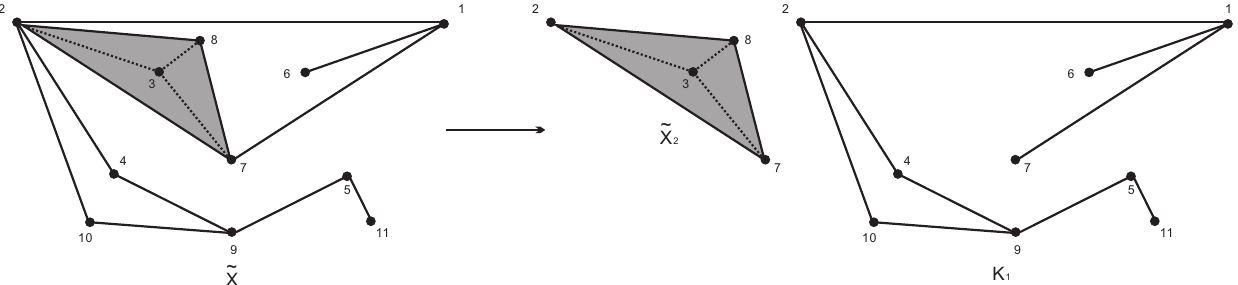
Figure 6. Topological stratification. ˜ X stratifies into a sub-complex ˜ X 2 induced by all 2-simplices and K 1 induced by the remaining